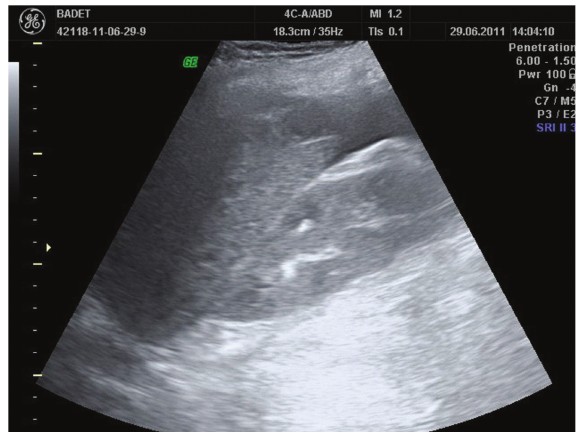
Figure 2: Liver ultrasound after 15 minutes reveals growth of the subcapsular hematoma.